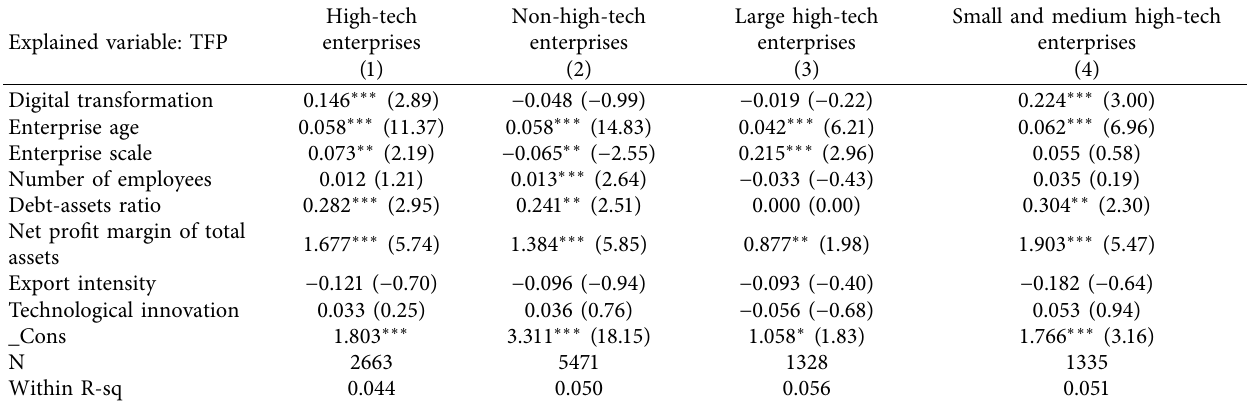
Table 4: Regression results of heterogeneity